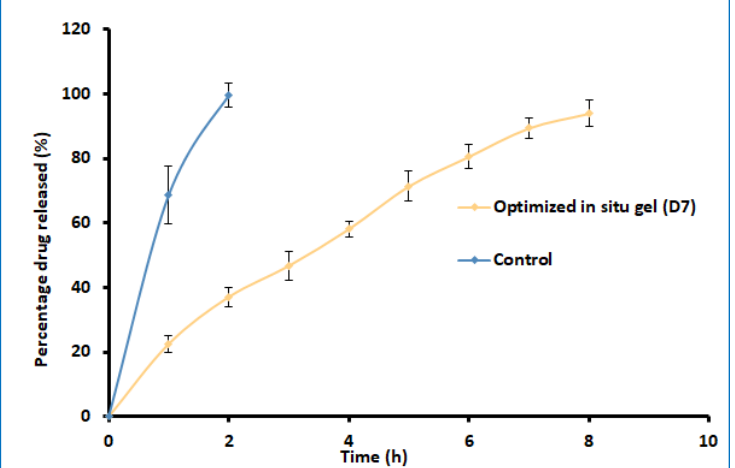
Figure 7. Comparison of percentages of darunavir release from optimized in situ gel (D7) and con- trol (suspension). The data presented are the average ± SD ( n = 6). (suspension). The data presented are the average ± SD ( n =